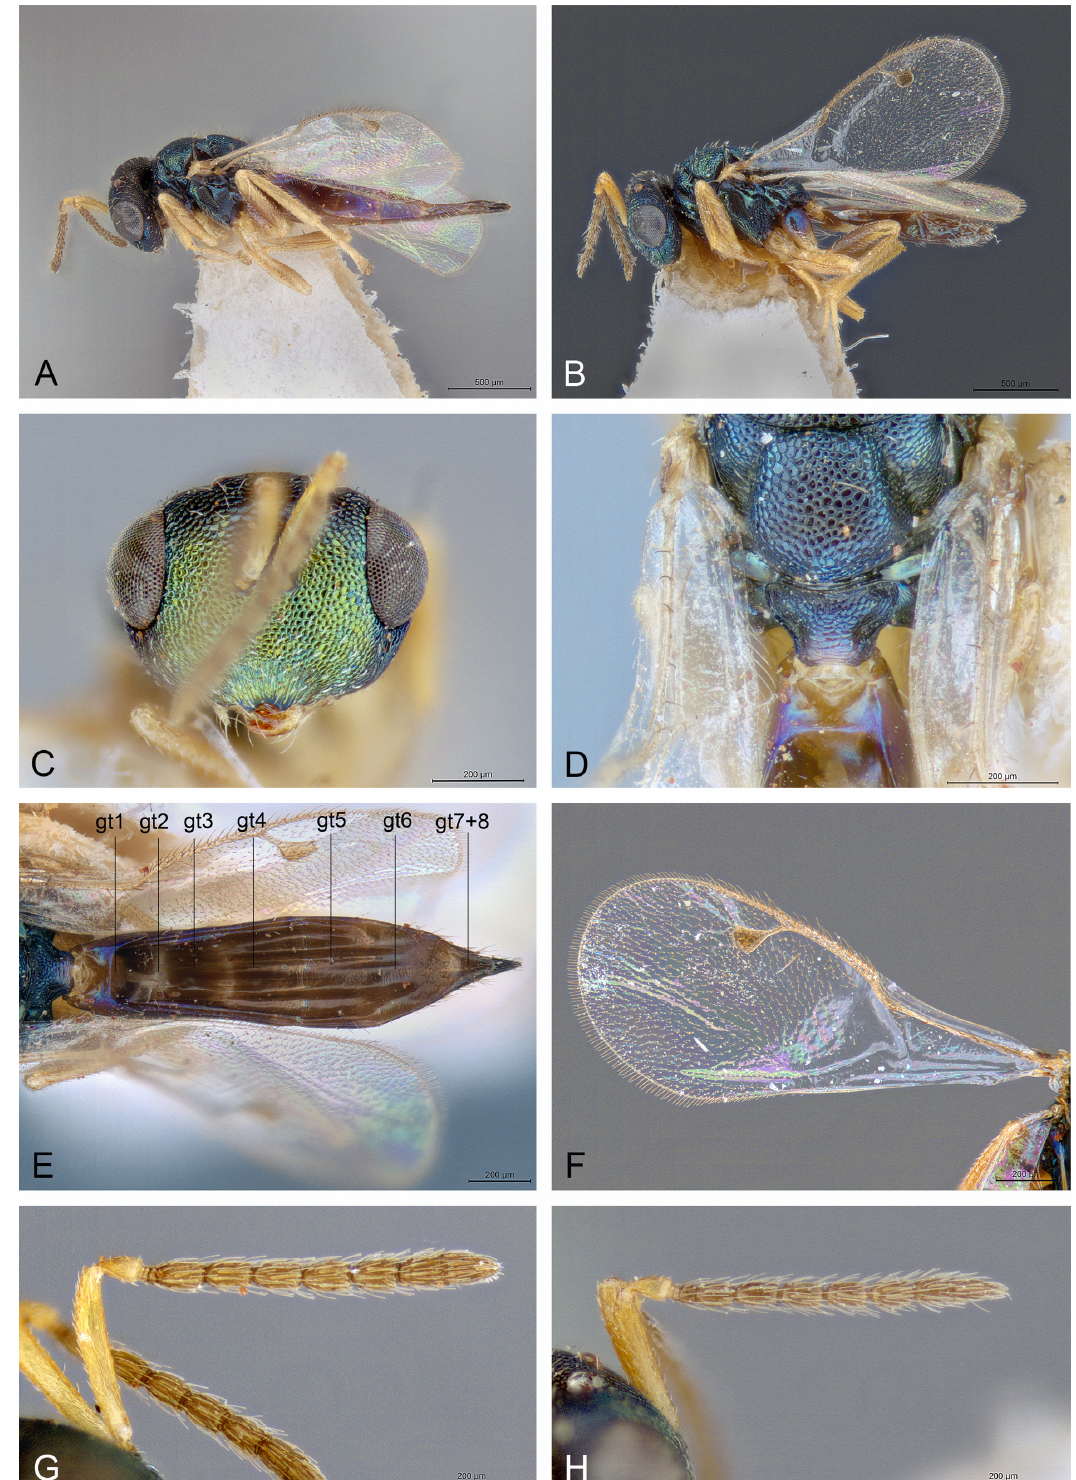
Fig. 4. Habritella viridifrons sp. nov. A, C–E, G . Holotype, ♀ (RMCA). B, H . Allotype, ♂ (RMCA). F . Paratype, ♀ (RMCA). A . Habitus in lateral view. B . Habitus in lateral view. C . Head in frontal view. D . Detail of mesosoma in dorsal view. E . Metasoma in dorsal view. F . Fore wing in dorsal view. G . Antenna in lateral view. H . Antenna in lateral 170